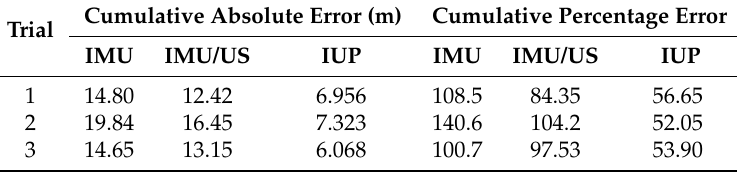
Table 1. The cumulative absolute and percentage errors of inertial measurement unit (IMU), IMU/ultrasound (US) and inertial/ultrasound/particle filter (IUP) systems for all three trials during Type 1 walking. For trial 1, this corresponds to the area under the curves in Figure 4b,c. As these are cumulative errors across all the steps taken, they are not true percentages or distances, and hence the cumulative percentage error is not bound in the range